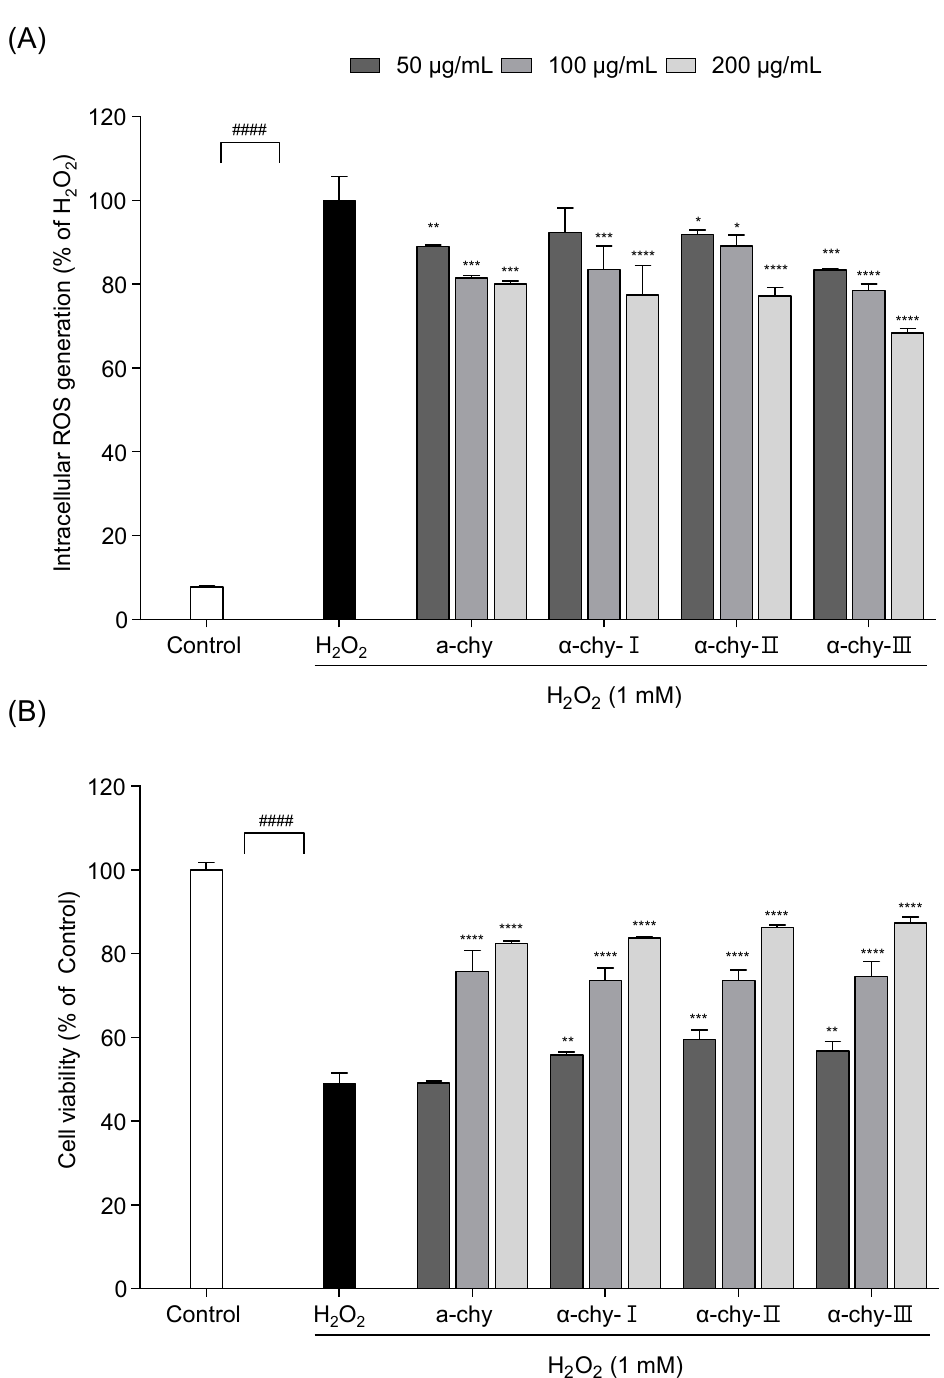
Figure 3. α -chy and its UF fractions suppress H 2 O 2 induced oxidative damage in vitro Vero cells. Intracellular ROS scavenging activity ( A ) and cell viability ( B ) in H 2 O 2 exposed Vero cells. Experiments were performed in triplicate and data are expressed as mean ± SD; Significant differences identified at * p < 0.05, ** p < 0.01, *** p < 0.001 and **** p < 0.0001 as compared to the H 2 O 2 treated group; #### p < 0.0001 as compared to the control group.